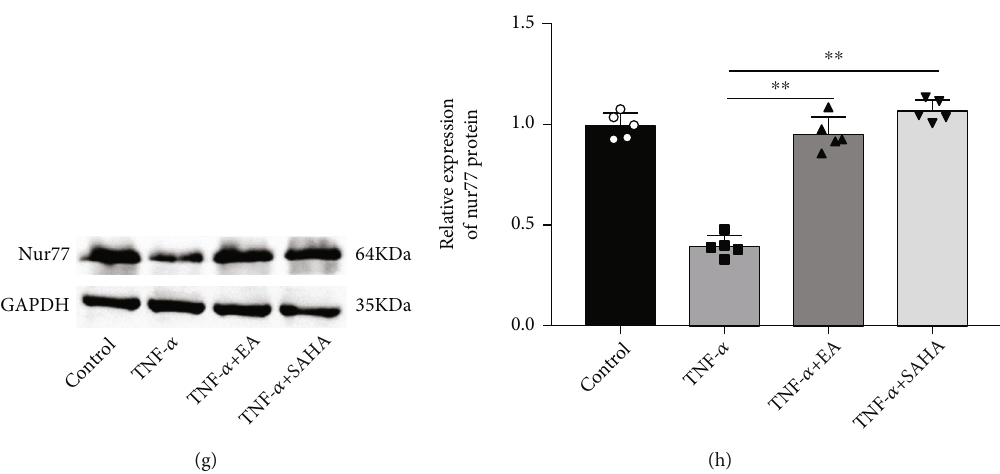
Figure 5: EA inhibited HDAC1-mediated Nur77 deacetylation in MH7A cells. (a) ChIP was employed to detect the enrichment of HDAC1 on the Nur77 promoter region in MH7A cells after HDAC1 overexpression. (b – d) MH7A cells we transfected with pcDNA-HDAC1 alone or together with treatment with 5 μ M HDAC1 inhibitor SAHA, the mRNA and protein expression of Nur77 was detected by RT-qPCR and Western blot analysis, respectively. (e) TNF- α -treated MH7A cells were treated with 50 μ M EA; ChIP was employed to detect the enrichment of HDAC1 in the Nur77 promoter region in MH7A cells. (f – h) The mRNA and protein expression of Nur77 was detected by RT-qPCR and Western blot analysis, respectively. Data from at least three replicate experiments were presented as mean ± SD . N = 5 . ∗∗ P < 0 : 01